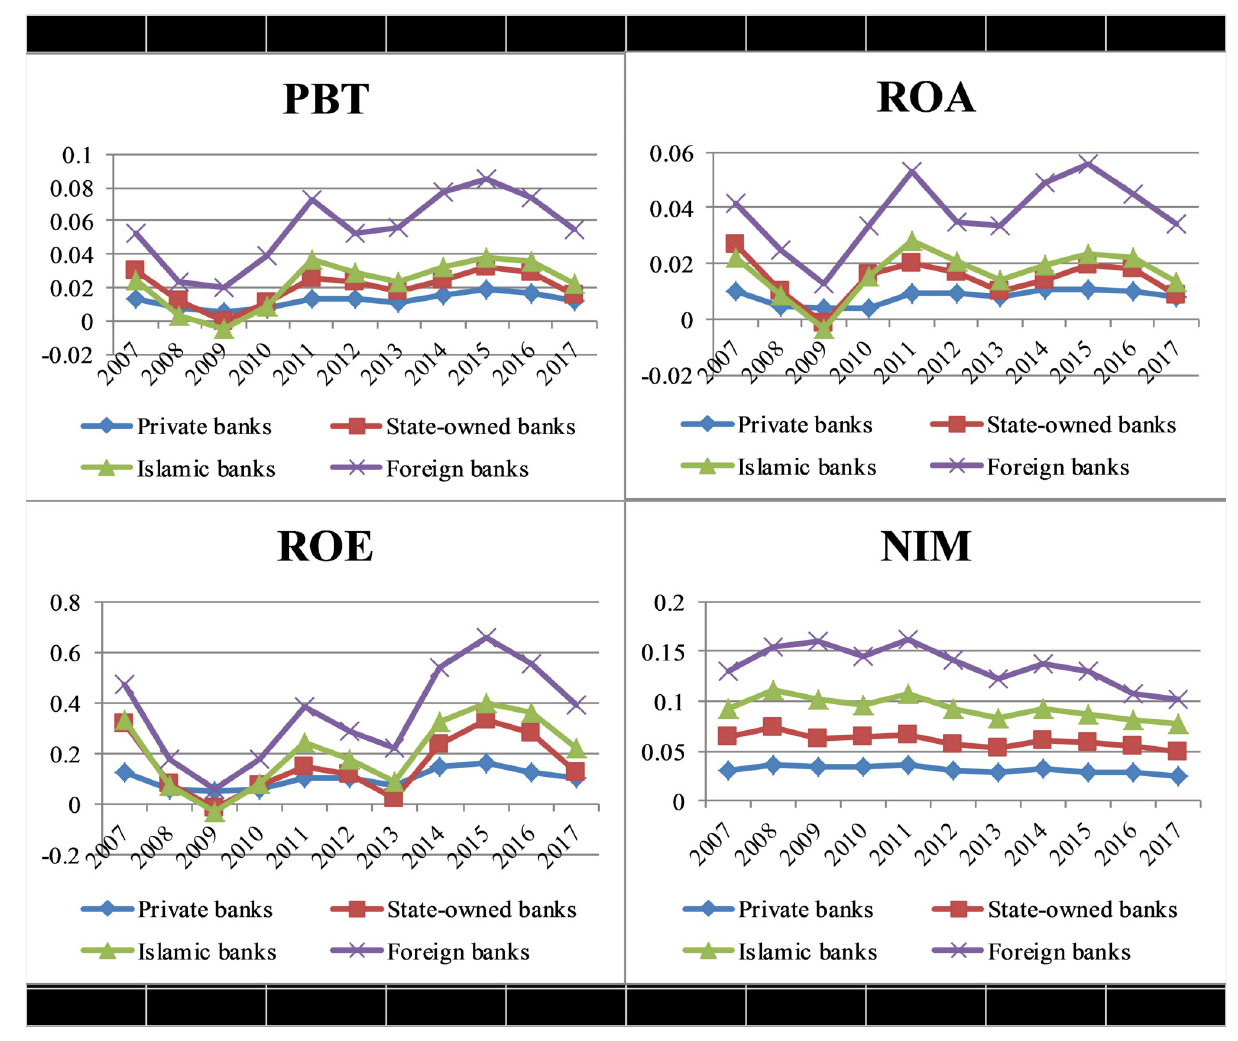
Fig 1. Profitability indicators of Pakistani